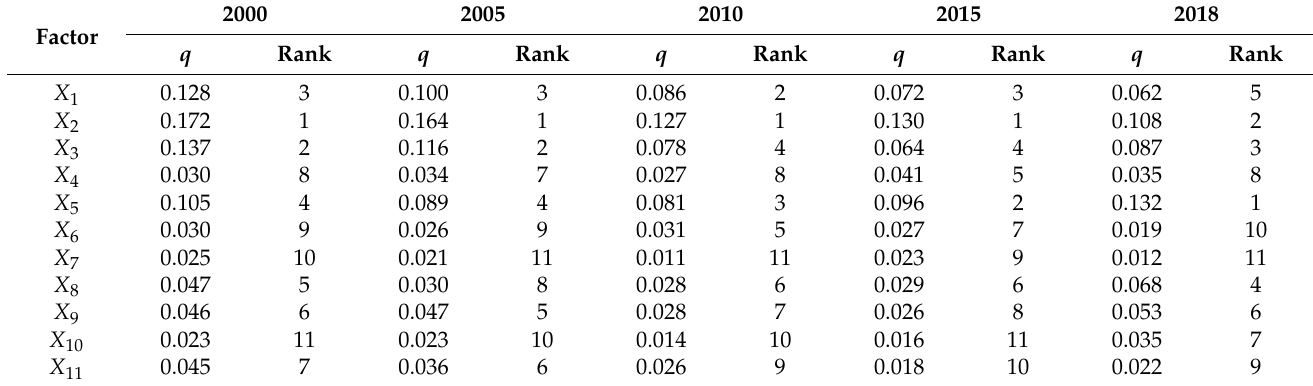
Table 4. Factor detection results for the spatial differentiation of the non-grain production rate in